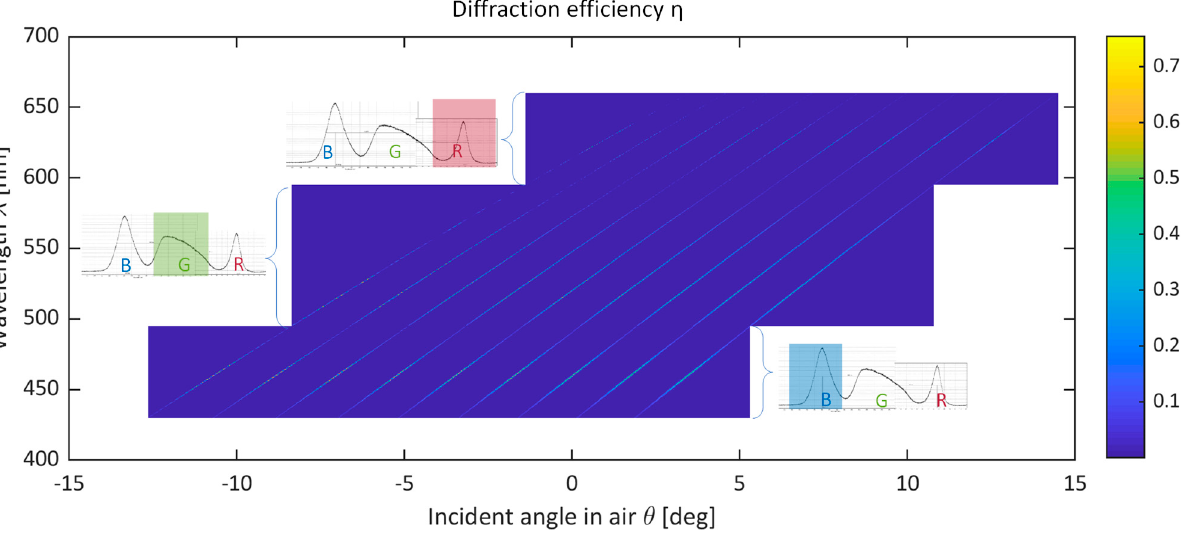
Figure 5. Spectral-angular diagram for the full spectrum of the MiniRay projector.